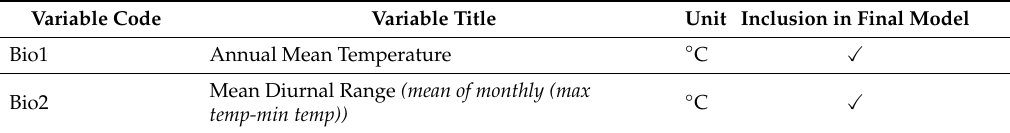
Table 1. List of bioclimatic variables used in this study. These variables, created by Fick and Hijmans (2017), were downloaded as 2.5 min (5 km 2 ) resolution environmental layers from worldclim.org. Variables used monthly climate data collected over 30 years between 1970 and 2000. A subset of bioclimatic variables, identified by tick marks, was produced by stepwise regression analysis to be used in the BIOCLIM and MAXENT modelling